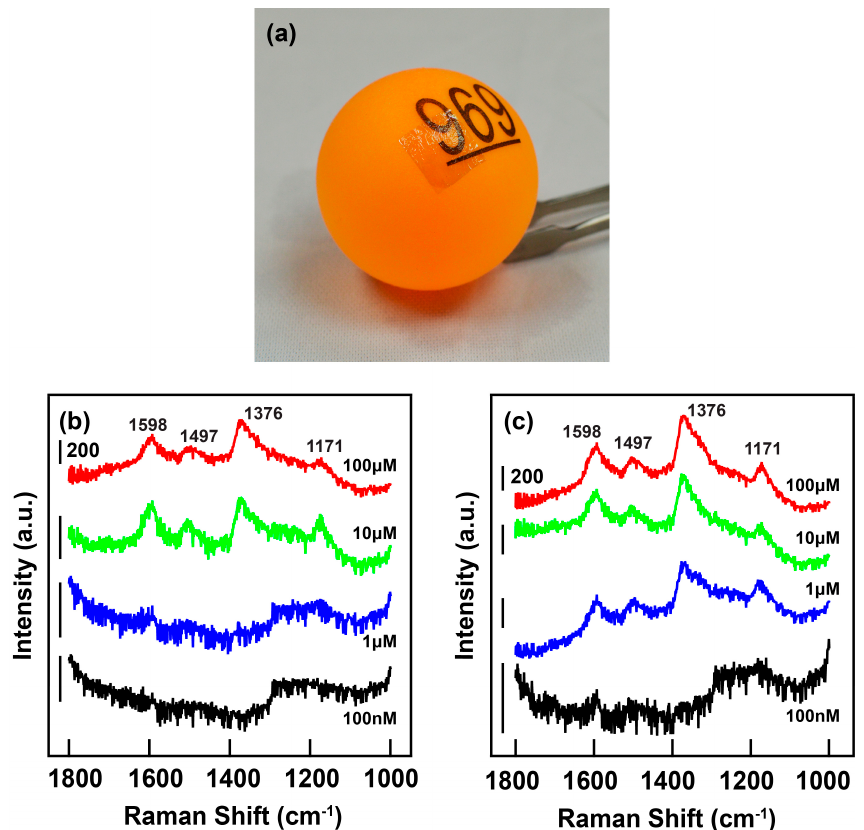
Figure 4. Flexible SERS substrate. ( a ) Digital photograph of the flexbile SERS substrate stuck onto the surface of a table tennis ball; ( b ) Raman spectra of the PANI-ES molecules of different concentrations collected from the empty PS substrate; ( c ) Raman spectra of the PANI-ES molecules of different concentrations collected from the flexible SERS substrate. The excitation wavelength for ( b , c ) is 1064 nm. The baselines of the Raman spectra have been modified for better demonstration.